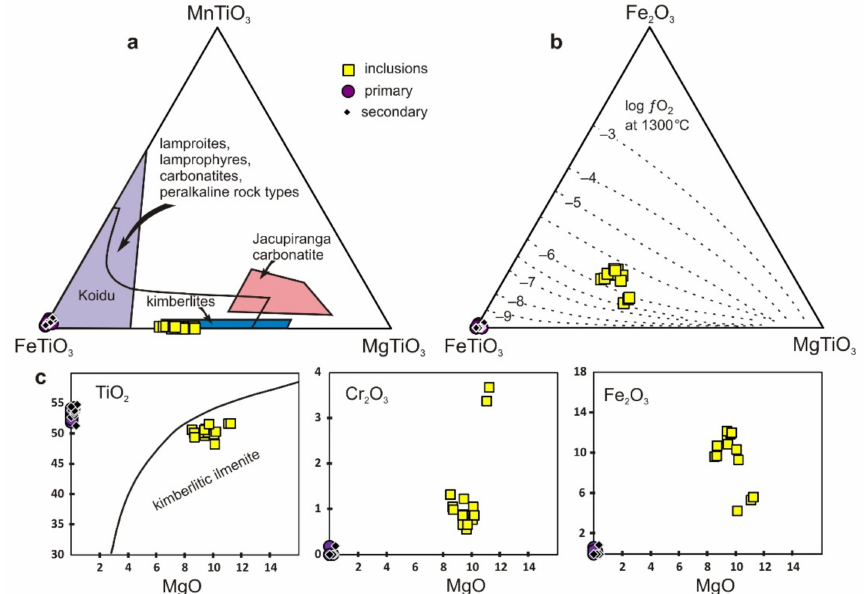
Figure 6. Ternary ( a , b ) and binary ( c ) diagrams, showing compositional variations in ilmenite in- clusions (“inclusions”) in olivine macrocrysts; primary ilmenites (“primary”) from the groundmass of the Terina UMLs and secondary ilmenites replacing Ti-magnetite and Cr-spinels (“secondary”). Fields in ( a ) and log ƒO 2 isobars in ( b ) are taken from [47], kimberlite ilmenite line in ( c ) is af- ter [48]. The ilmenite compositions in ( c ) are given in wt%. Fe 2 O 3 concentrations are calculated from